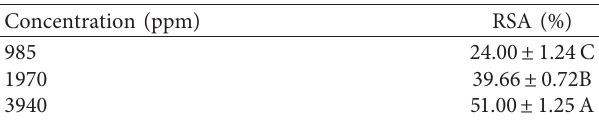
∗ Data represent mean ± standard deviation of three independent repeats. ∗∗ Different capital letters in each column indicate significant differences ( p < 0 . 05 ) . Table 3: Reducing power of Shahpouri orange juice (SOJ). Concentration (ppm)